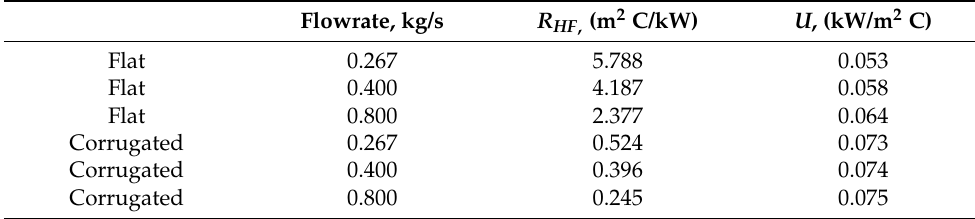
Table 2. Thermal resistance and overall heat transfer for the plate and corrugated plate.